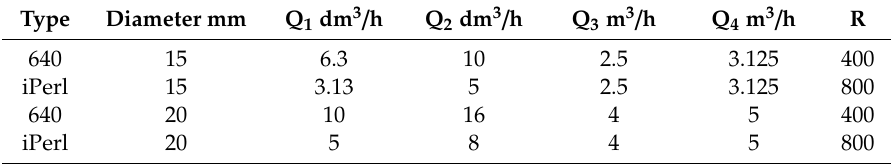
Table 3. The metrological parameters of installed and planned to be installed water